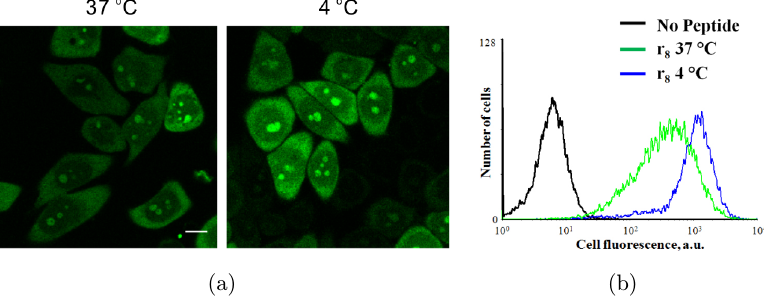
Fig. 3. E®ect of temperature on the cellular uptake of the FITC-labeled peptides. (a) Confocal microscopy images and (b) °ow cytometry analyses of living HeLa cells after incubation with the FITC-labeled r 8 (5 (cid:1) M) for 5 min in serum-free DMEM (300 (cid:1) L) at 37 (cid:2) C or 4 (cid:2) C. Scale bar: 10 (cid:1) m.